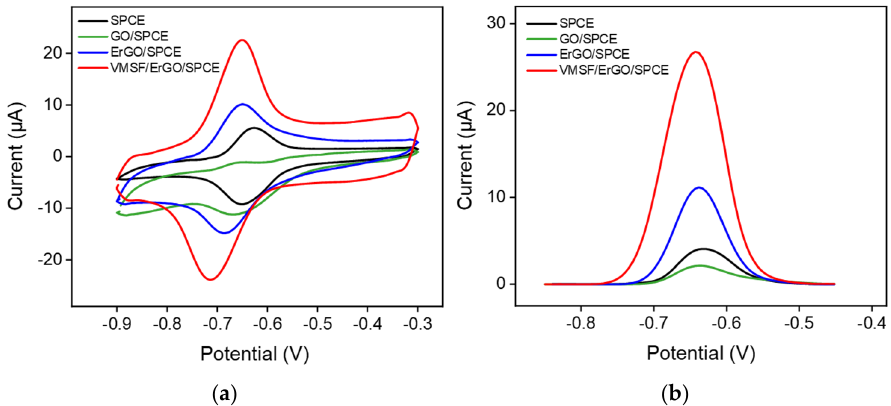
Figure 4. ( a ) CV and ( b ) DPV curves of bare SPCE (black), GO/SPCE (green), ErGO/SPCE (blue) and VMSF/ErGO/SPCE (red) in 0.1 M PBS (pH = 6.0) solution containing 10 μ M DOX. The scan rate in ( a ) was 100 mV/s, and the potential in ( b ) ranged from − 0.85 V to − 0.45 V.